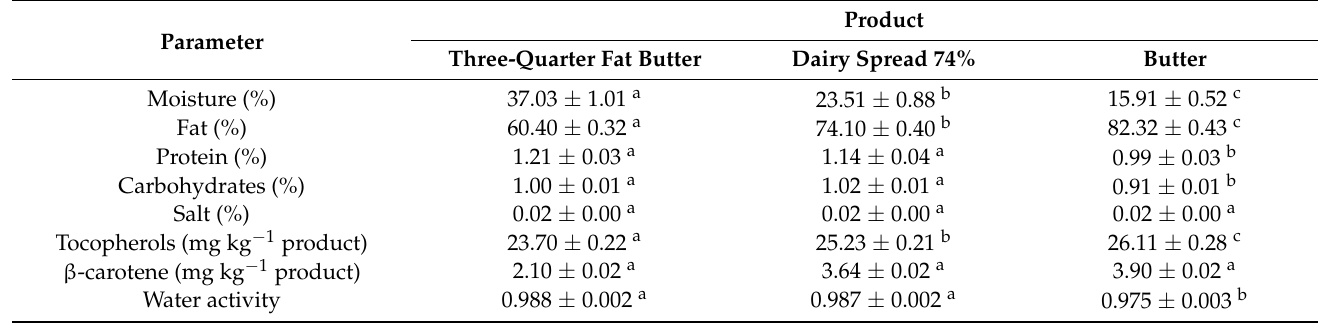
Table 1. Composition of the analysed products.